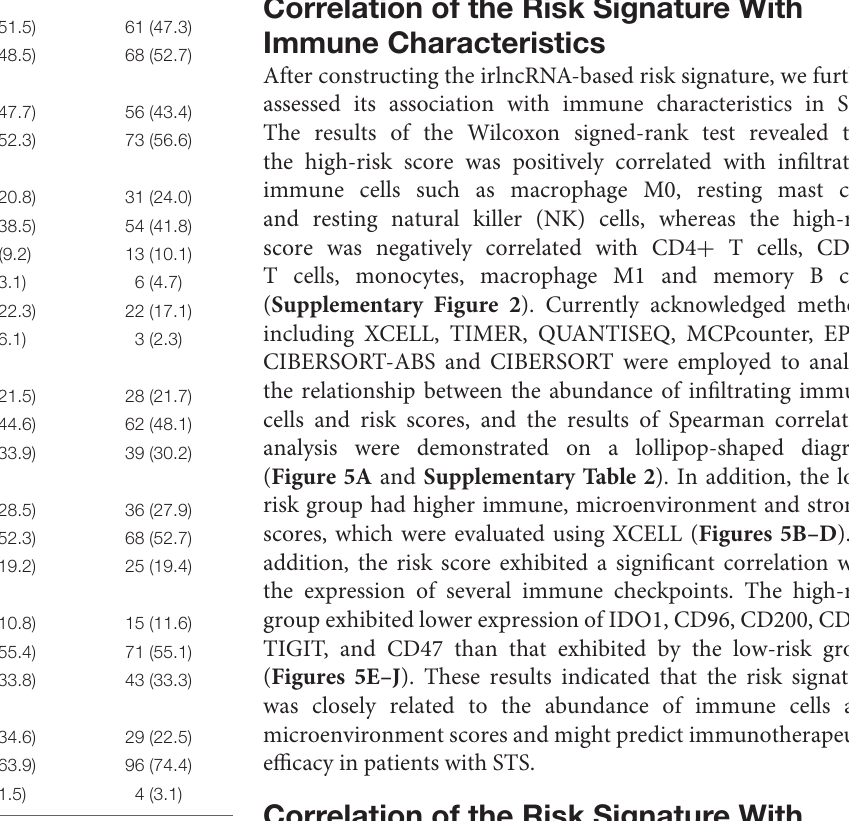
TABLE 1 | Clinical characteristics of STS patients in the training set and the validation set. Characteristics ( n ;